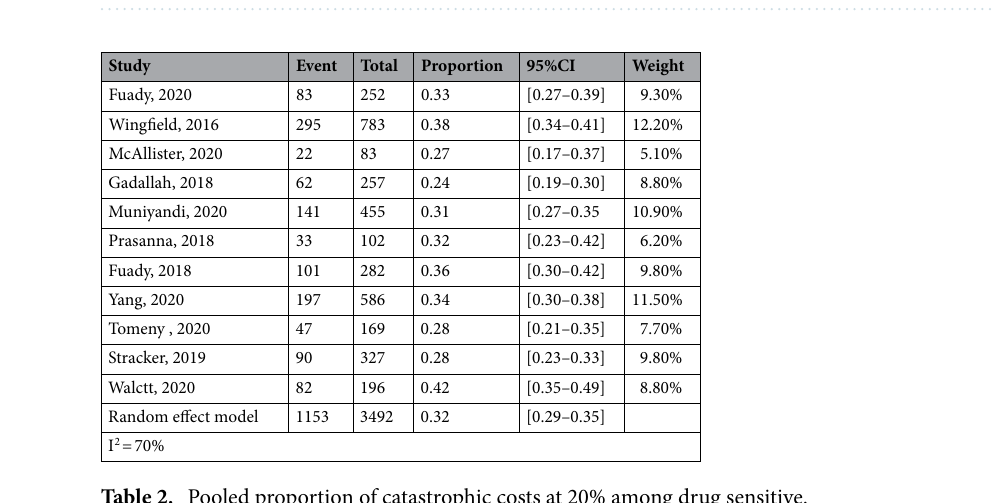
Figure 3. Pooled proportion of catastrophic costs incurred by TB patient and their household at a cut-off point of 20%.